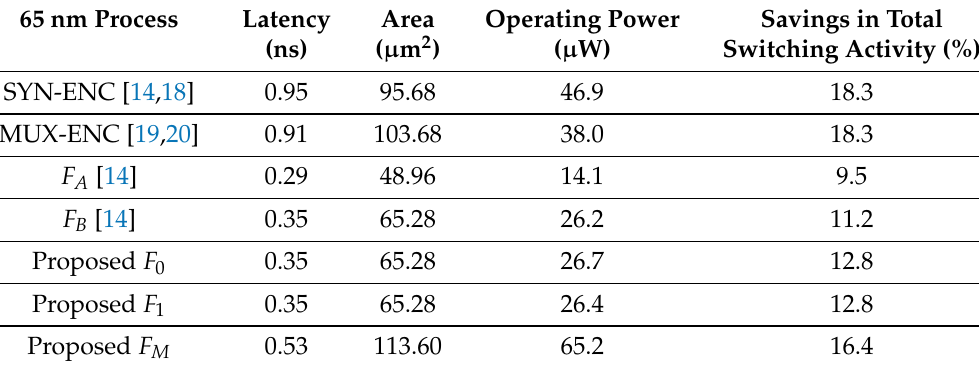
Table 3. Latency, area, power, and savings in switching activity of the encoders based on the proposed approximators and the majority